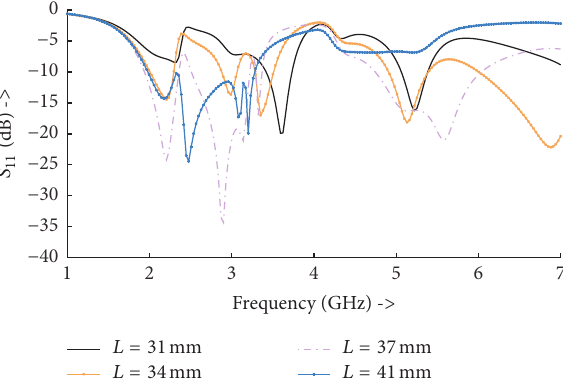
Figure 5: Simulated 2D radiation patterns.